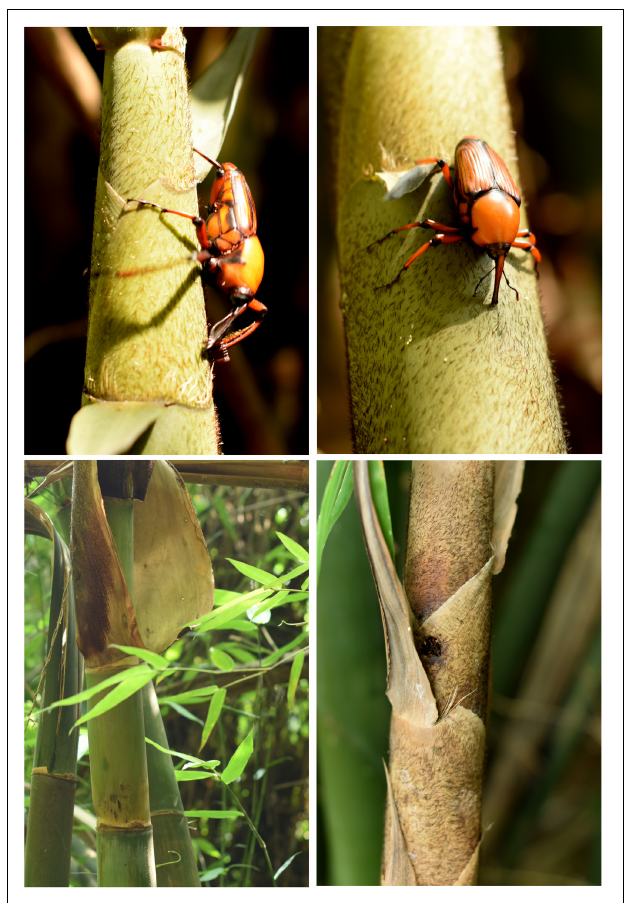
FIGURE 1 | Bamboo shoots and bamboo snout beetle C. buqueti